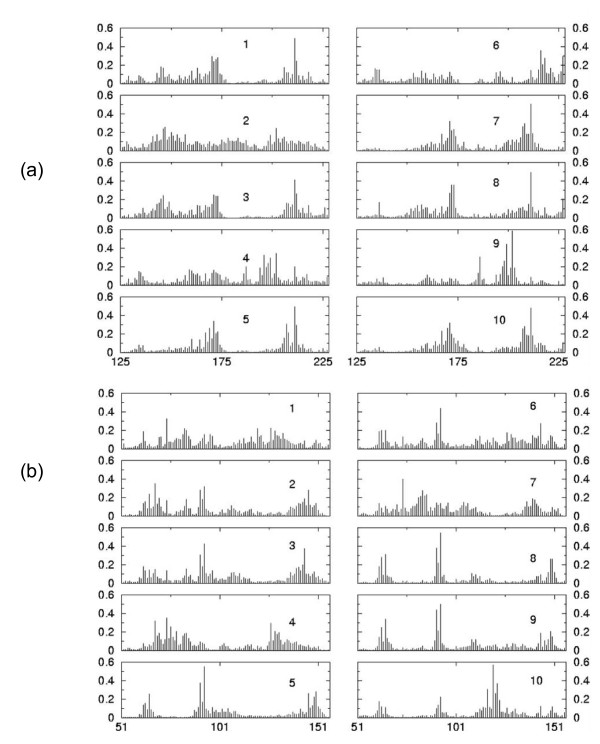
Energy Decomposition for the 10 most populated conformational clusters at 450 K. The components of the principal eigenvector of the residue-residue interaction matrices were calculated for the first 10 most populated conformational clusters for the simulations of PrP (a) and Dpl (b) at 450 K. The number in each graph corresponds to the cluster number.